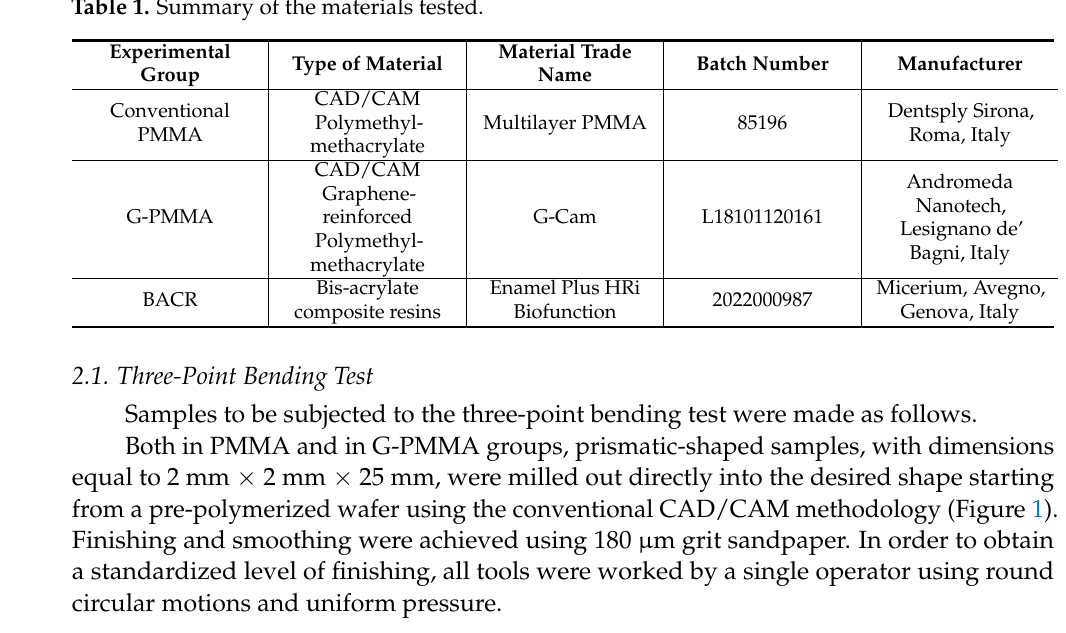
Table 1. Summary of the materials